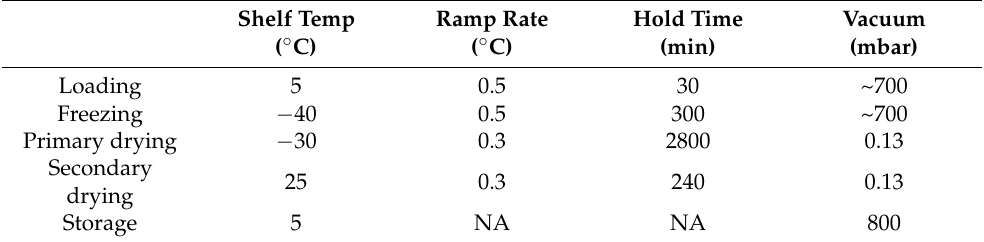
Table 1. Lyophilisation process parameters used to prepare prototype